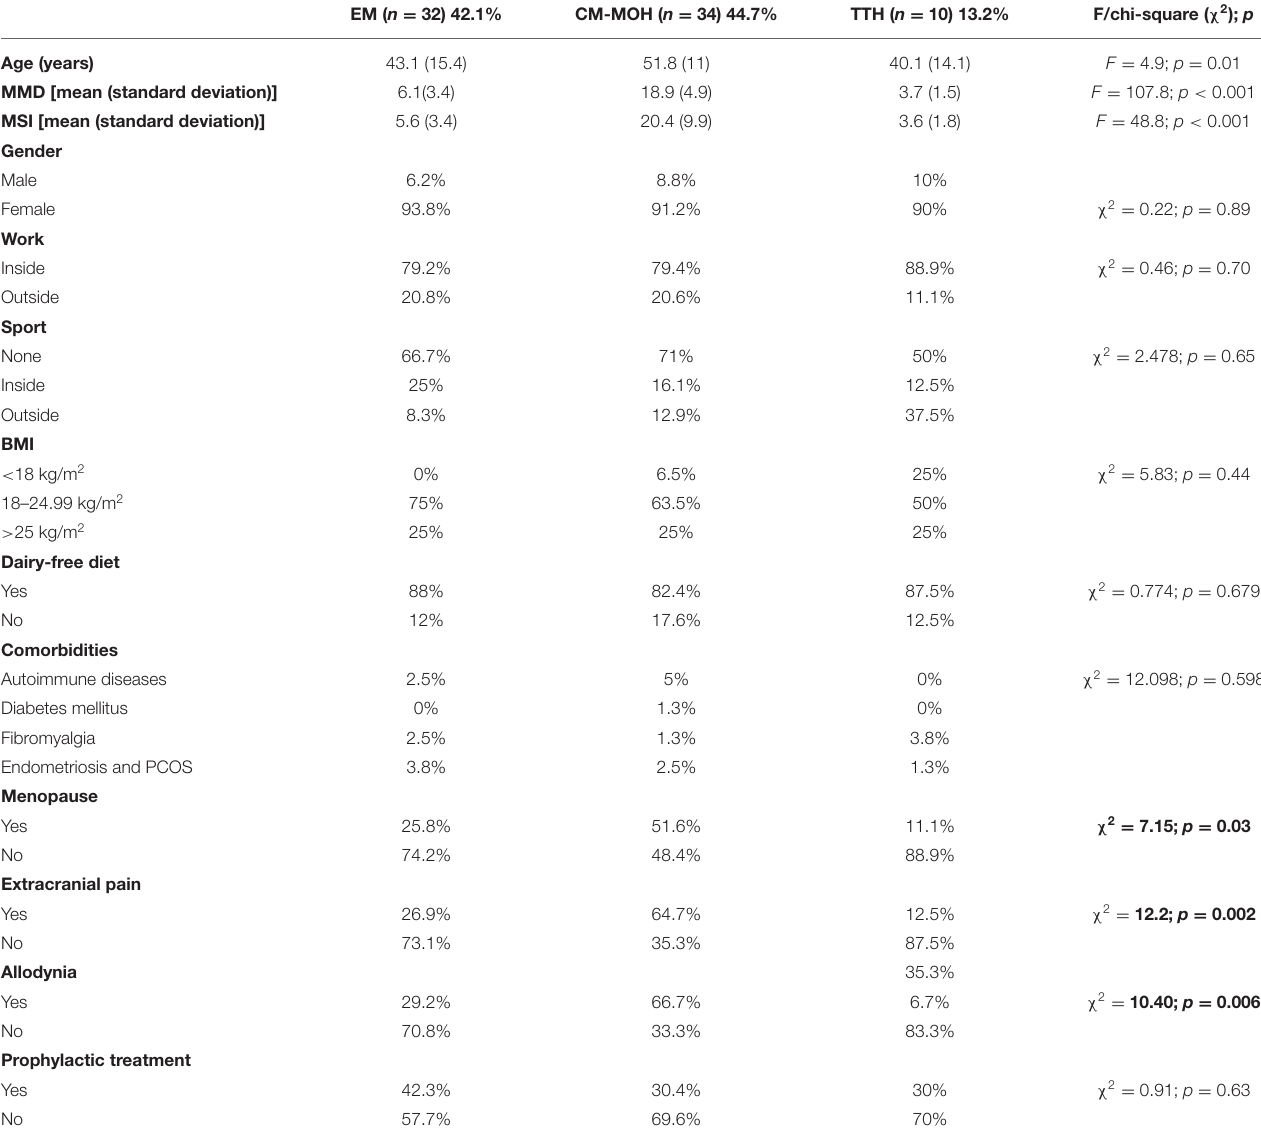
TABLE 1 | Demographic and clinical